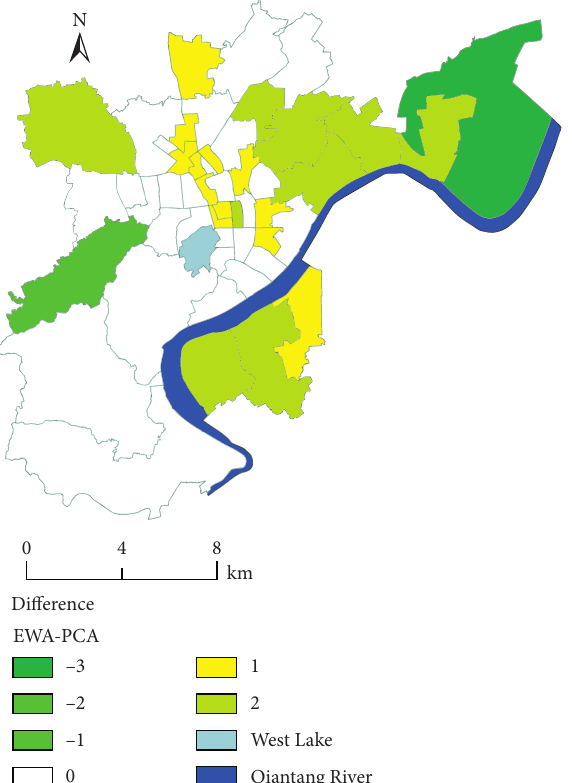
Figure 6: The regression between HRI and heat-related deaths at the subdistrict level.